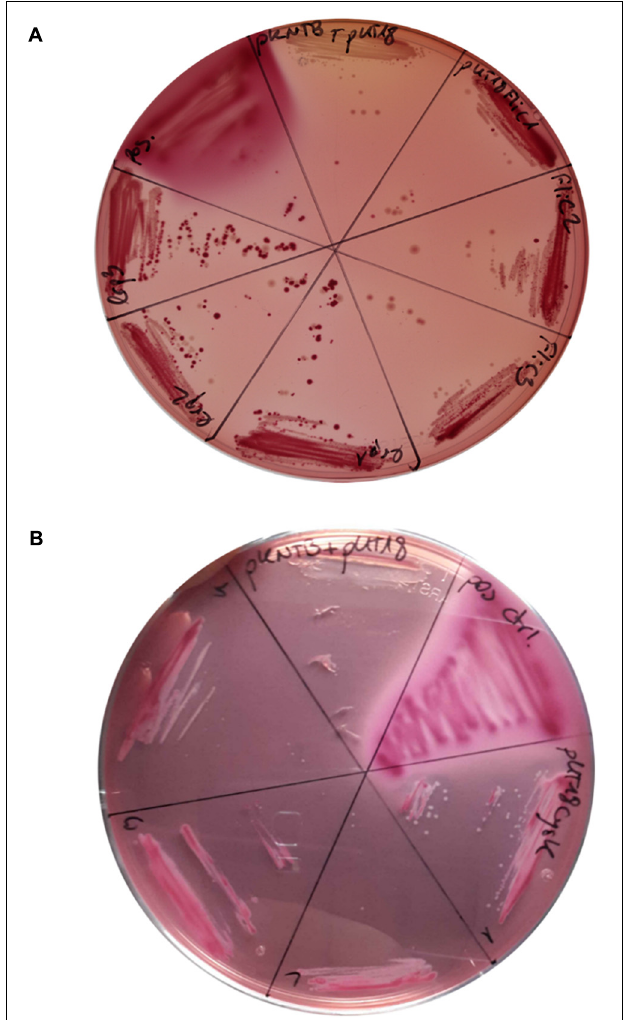
FIGURE 3 | Confirmation CdPpiB interaction partners with BACTH on MycKonkey-Agar. (A) E. coli BTH101 cells transformed with wt ppiB carrying pKNTB in combination with pUT18_FliC carrying wt fliC or pUT18_Lrp carrying wt lrp were streaked out on MacKonkey-agar and grown for 2 days at 30 ◦ C. (B) E. coli BTH101 cells transformed with wt ppiB carrying pKNTB in combination with pUT18_CysK carrying wt cysK were streaked out on MacKonkey-agar and grown for 2 days at 30 ◦ C. Purple coloring was indicative of protein interaction due to adenylate cyclase activity. On each plate E. coli BTH101 carrying empty pUT18 plasmid in combination with pKNTB served as negative control, whereas colonies carrying the pUT18-zip and pKT25-zip plasmids delivered by the manufacturer served as positive control. At least three colonies of each transformation were tested. Representative plates of three separate transformations are